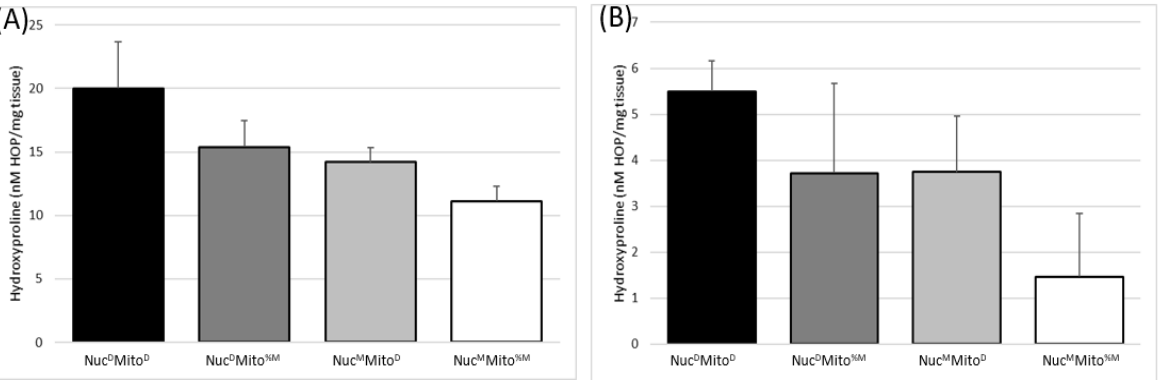
Figure 3. Quantitative MD phenotype analysis in the four mixed genome mouse lines. As in Figure 2 the mitochondrial genome is purely based upon maternal inheritance and the MRL mitochondrial genomes are undefined heteroplasmic (Mito %M ). Both MRL nuclear and mitochondrial genomes de- crease the fibrosis/hydroxyproline levels in the ( A ) diaphragm and ( B ) cardiac ventricles. Nuc D Mito D (black bars), Nuc D Mito %M (dark grey), Nuc M Mito D (light gray), and Nuc M Mito %M (white bars). N > 7, averages with standard deviations.